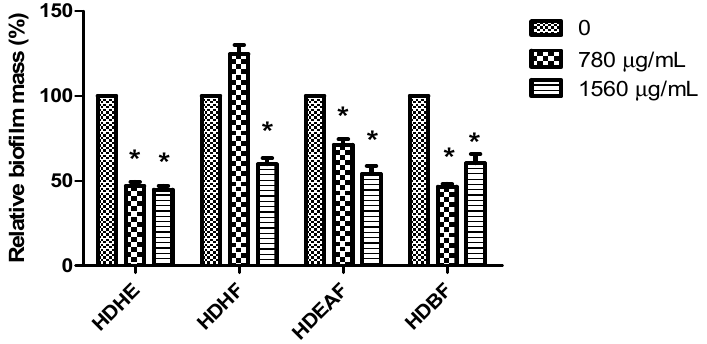
Figure 1. Inhibition of Klebsiella. pneumoniae biofilm by hydroalcoholic extract from leaves of Himatanthus drasticus and its fractions. HDHE: H. drasticus hydroalcoholic extract; HDHF: H. drasticus hexane fraction; HDEAF: H. drasticus ethyl acetate fraction; HDBF: H. drasticus butanolic fraction. * p < 0.05 in relation to untreated biofilm (control). The tests were performed in two independent assays in quadruplicate.